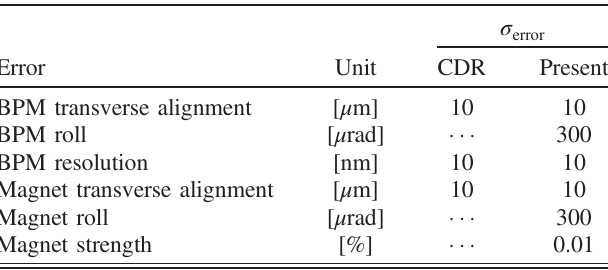
TABLE I. List of considered static imperfections included in the past (CDR) and the current